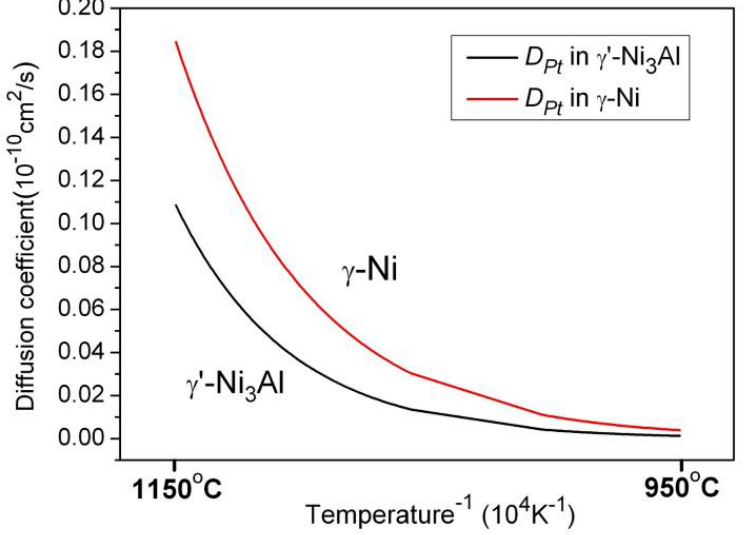
Figure 10. Diffusion coefficient of Pt in the γ-Ni and γ’-Ni 3 Al phase as a function of temperature between 950 °C and 1150 °C.